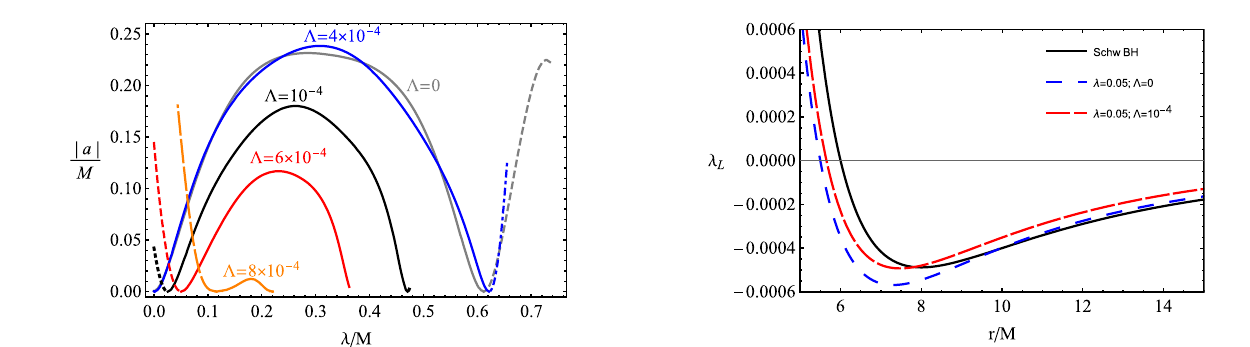
Fig. 5 The degeneracy relation between the values of the spin param- eter of Kerr BH and the PFDM parameter, λ for which the radius of ISCO for the Kerr BH is the same as the ISCO for the Schwarzschild BH surrounded by PFDM in a de Sitter spacetime. In this plot, we use Λ → Λ/ M 2